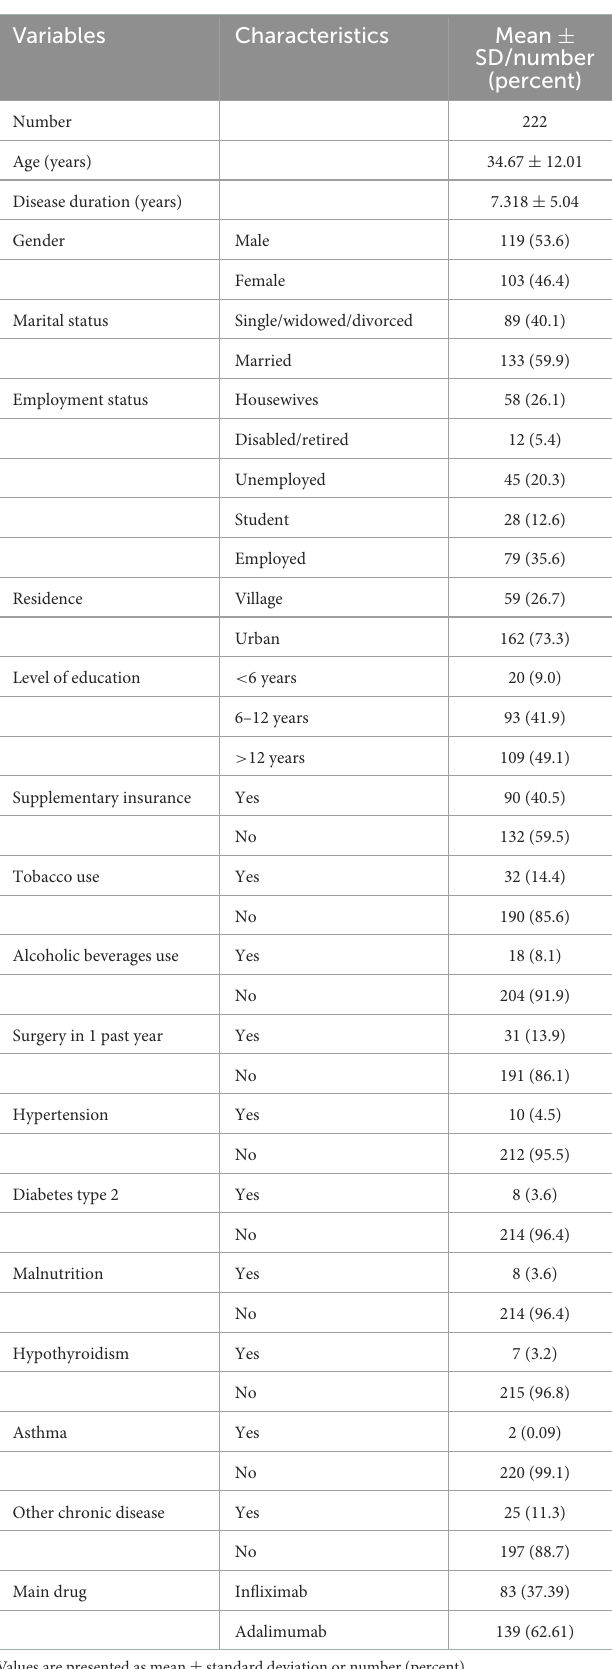
TABLE 1 Socio-demographics and clinical characteristics of CD patients.